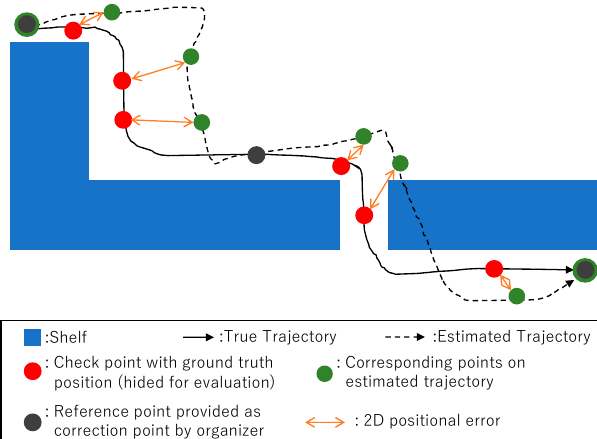
Figure 5. Evaluation metric for E d is determined by calculating the distance between the ground-truth position of check points (colored in red) and corresponding points on an estimated trajectory (colored in green). The ground-truth data that are used for evaluation are discrete points obtained by the warehouse management system (WMS), and do not form a continuous path. We partially provide the ground-truth points (colored in gray) for correcting the error. At these points, the error can be canceled to 0.